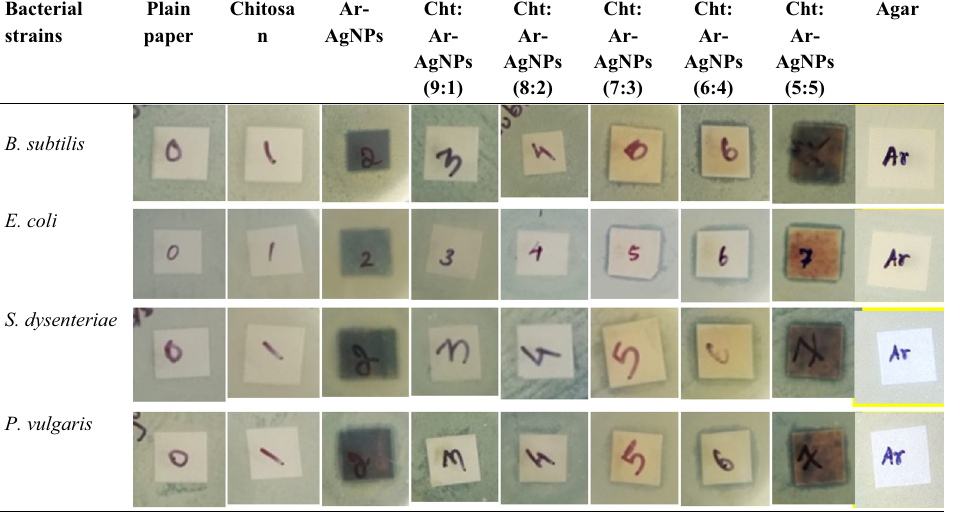
Figure 7: Antibacterial activity of plain paper, chitosan, agar, Ar - AgNPs - coated paper, and coated papers with di ff erent ratios of chitosan and Ar - AgNPs.